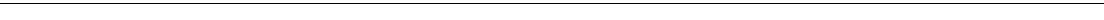
Figure 3 | EC polarization by blood flow is reversible. ( a – d’ ) Three-dimensional-rendered confocal stack images of 48h.p.f. Tg(kdrl:NLS-EGFP);Tg(fli1a: B4GALT1-mCherry) embryos uninjected ( a , b , b’ ) or injected with tnnt2a MO ( c , d , d’ ). White boxes in left panels ( a , c ) enlarged in middle panels ( b , d ). ( b’ , d’ ) Surface-rendered images of boxed regions. White arrowheads point to polarized ECs and yellow arrowheads point to non-polarized ECs. Yellow dashed lines indicate ventral boundary of DA. ( e ) Quantification of EC polarization. Numbers of larvae ( n ) and ECs ( n’ ) indicated above the graph. ( f ) Three-dimensional-rendered confocal stack images of 36h.p.f. Tg(kdrl:NLS-EGFP);Tg(fli1a:B4GALT1-mCherry) embryo injected with tnnt2a MO. ( g ) Time-lapse confocal images of white boxed region in ( f ) surface-rendered images displayed below; yellow arrowheads point to non-polarized ECs; time (hours:minutes) shown in the top right corner of the images. ( h ) Three-dimensional-rendered confocal stack images of Tg(kdrl:NLS-EGFP);Tg(fli1a: B4GALT1-mCherry) larva treated with 10mM BDM starting at 96h.p.f. ( i ) Time-lapse confocal images of white boxed region in ( h ) surface-rendered images displayed below; white arrowheads point to polarized ECs and yellow arrowheads point to depolarized ECs; red bars indicate diameter of the DA; time (hours:minutes) shown in the top right corner of the images. ( j ) Schematic representation of EC depolarization when blood flow stops. ( k ) Schematic time table of BDM treatment of Tg(kdrl:NLS-EGFP);Tg(fli1a:B4GALT1-mCherry) embryos before 72h.p.f.. ( l – s ) Three-dimensional-rendered confocal stack images of Tg(kdrl:NLS-EGFP);Tg(fli1a:B4GALT1-mCherry) embryos and larvae treated with 10mM BDM for 12h ( l , m ) or 10mM BDM for 12h, then dimethylsulfoxide (DMSO) for 12h ( n , o ), or treated continuously with 10mM BDM ( p , q ) or DMSO ( r , s ) for 24h. White arrowheads point to polarized ECs and yellow arrowheads point to non-polarized ECs. ( t ) Quantification of EC polarization of 60 or 72h.p.f. Tg(kdrl:NLS-EGFP);Tg(fli1a:B4GALT1-mCherry embryos and larvae treated with BDM for 12h, BDM for 12h then DMSO for 12h, BDM for 24h and DMSO for 24h. Numbers of larvae ( n ) and ECs ( n’ ) are indicated above the graph. Anterior to the left, dorsal to the top. Scale bars, 20 m m. DA, dorsal aorta; PCV, posterior cardinal vein. Error bars,